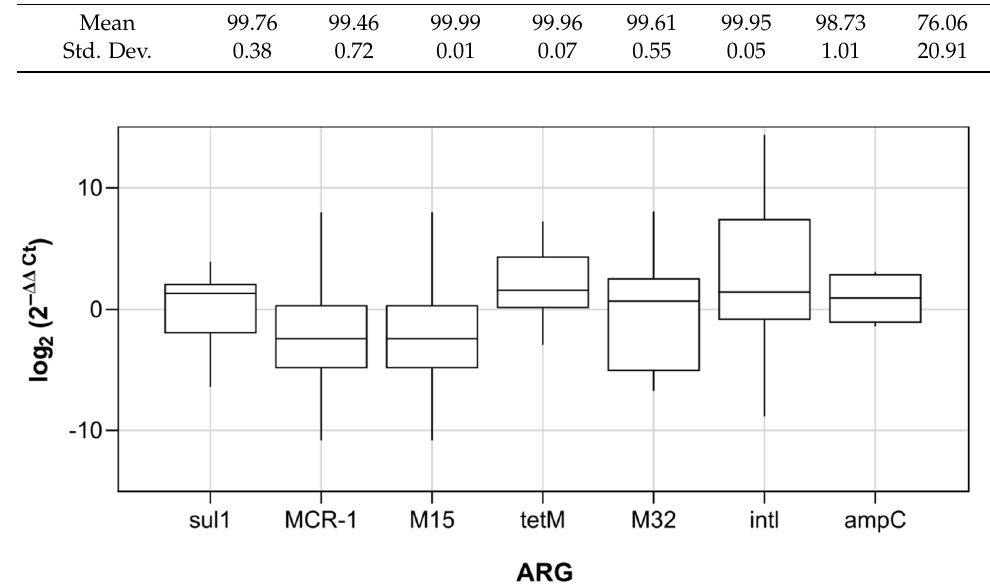
Figure 8. The difference in normalized fold gene expression level of the ARGs between the surface water taken upstream and downstream of the WWTP.